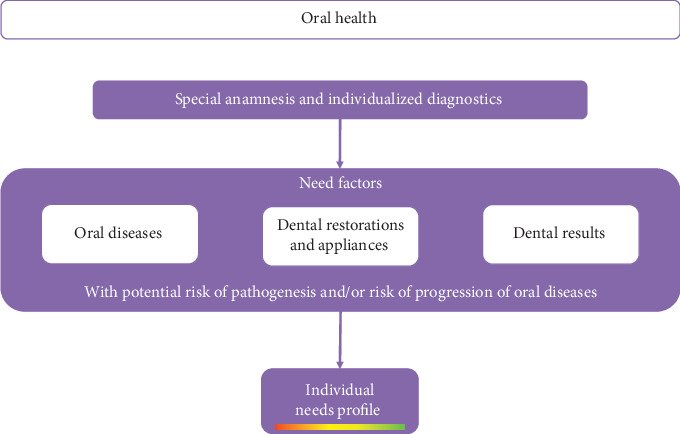
Based on a special anamnesis and individualized diagnostics, need factors originating from existing oral diseases, dental restorations, and appliances as well as dental findings determine patient needs profiles.